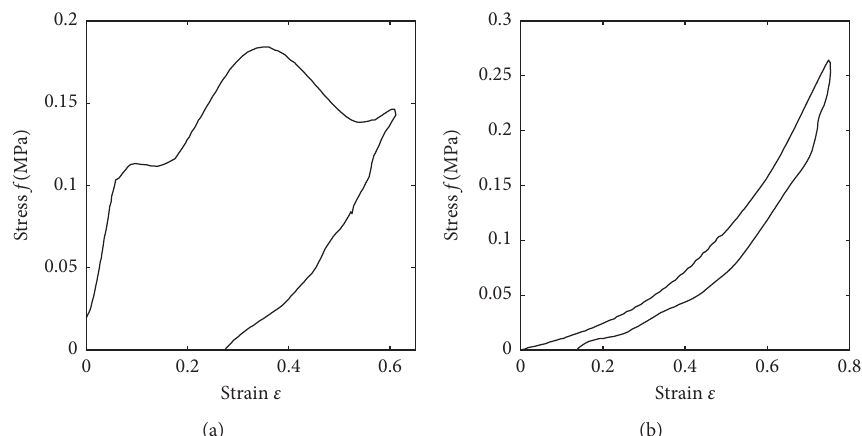
Figure 3: Dynamic stress-strain experimental data of the two cushioning materials. (a) Corrugated paperboard; (b) expanded polyethylene.